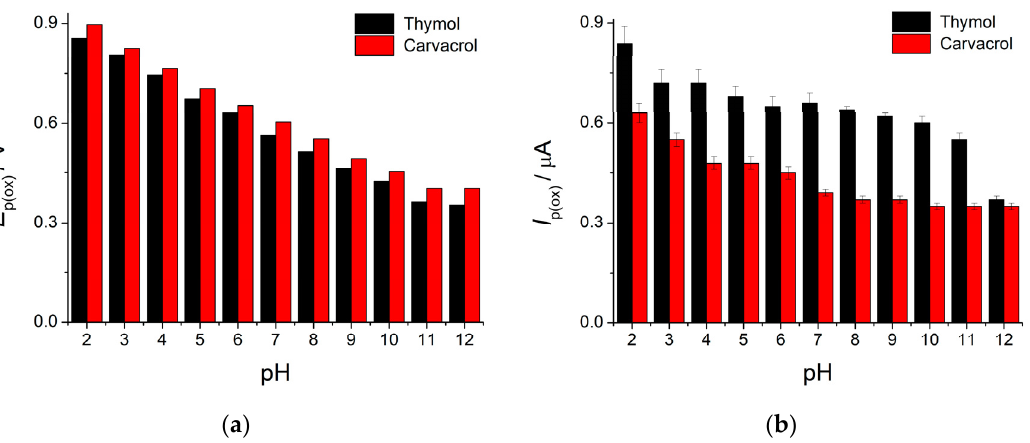
Figure 7. Effect of Britton–Robinson buffer pH on the voltammetric characteristics of 25 µ M isopropy- lmethylphenols at the polythymolphthalein/MWCNTs/GCE: ( a ) changes in the oxidation potentials; ( b ) changes in the oxidation